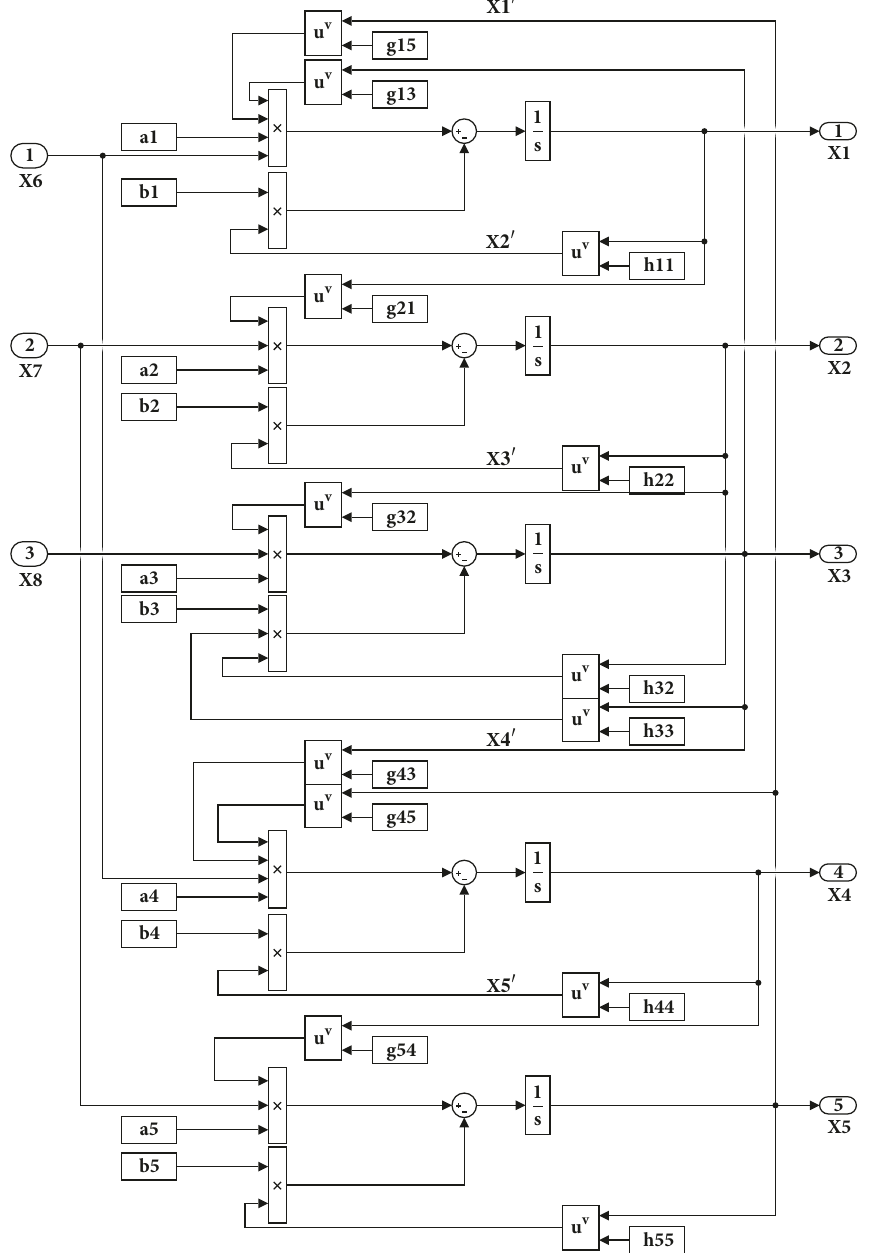
Figure 8: The block diagrams for the small scale genetic